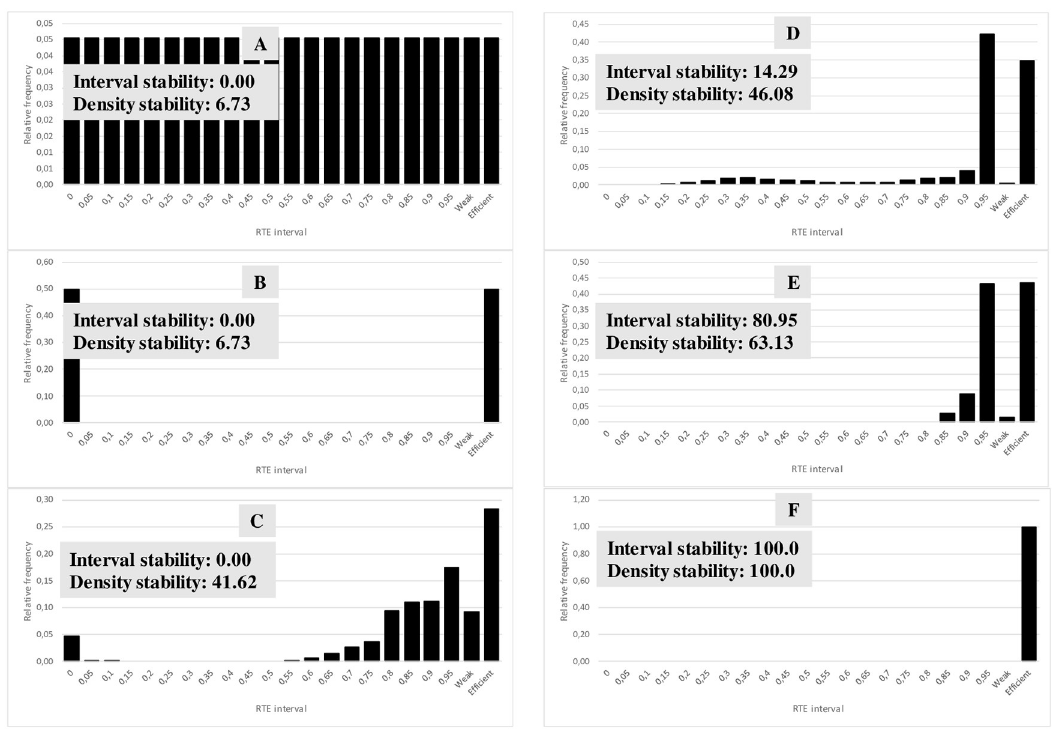
Fig 3. Some examples of different RTE statistical distributions and their corresponding stabilities ( inttot = 22, prob = 0.8, minln = 1.2909 and maxln = 4.6051). For the example in E: ninti = 5, acprobi = 0.88, nintprobi = 3, wint = 0.5 and wden = 0.5. Finally, the resulting stabE = 72.04 (likely stable).